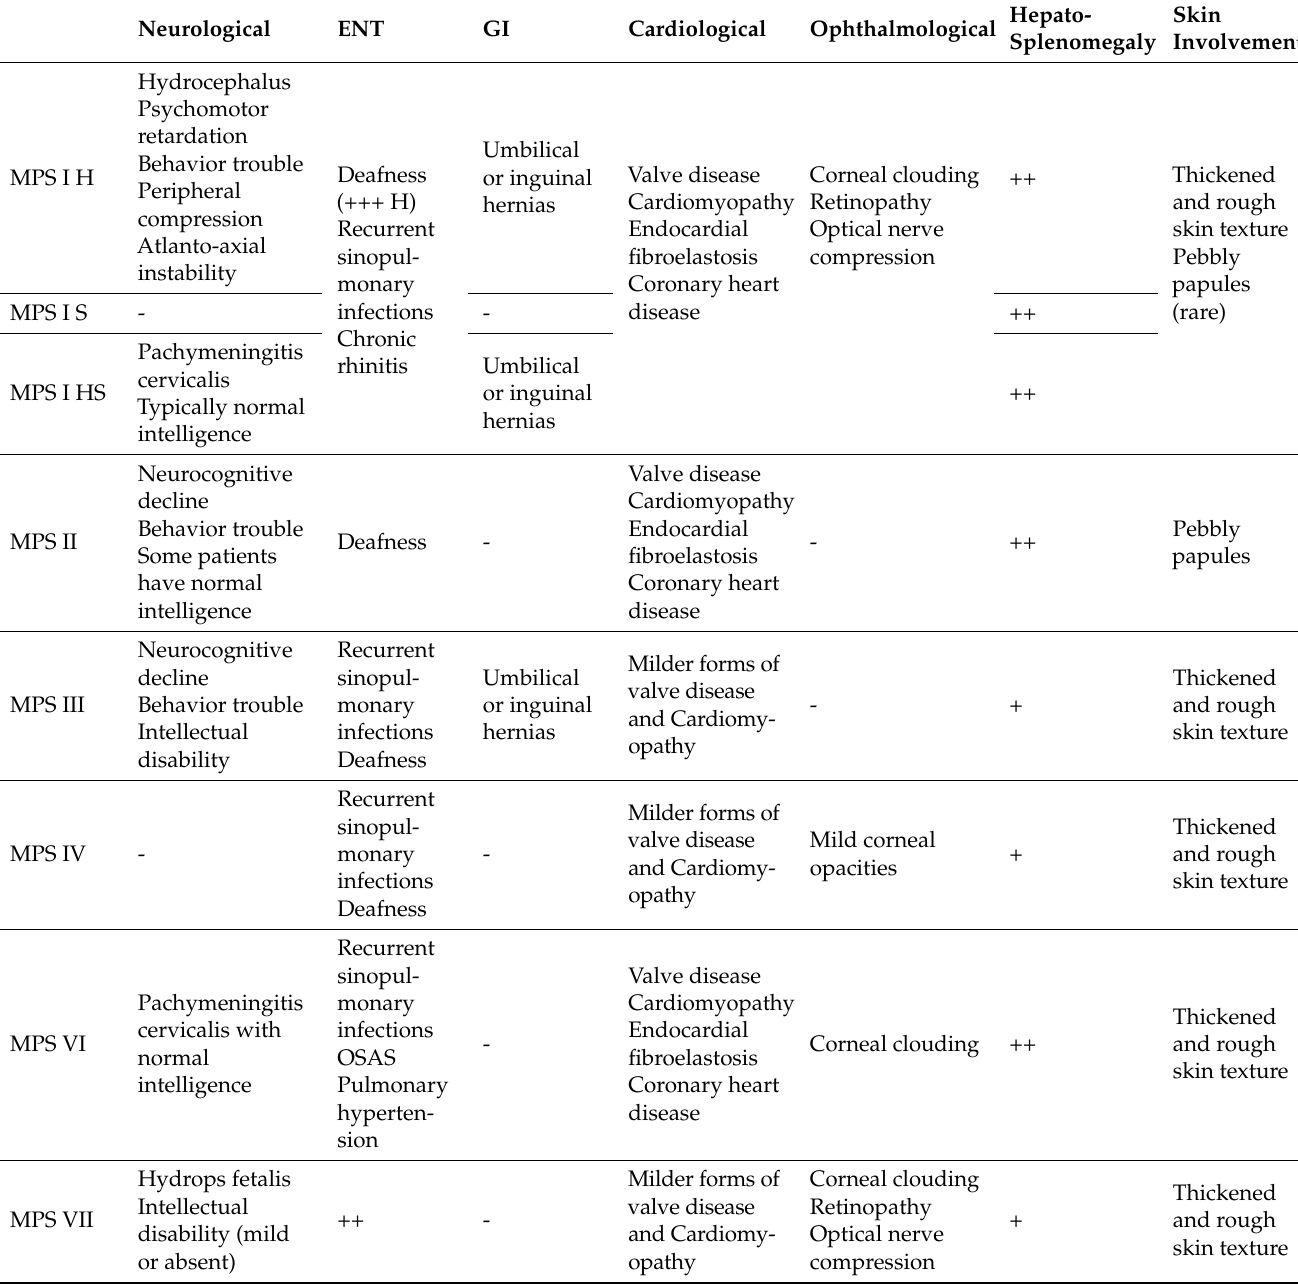
Table 5. Non musculoskeletal features of different type of